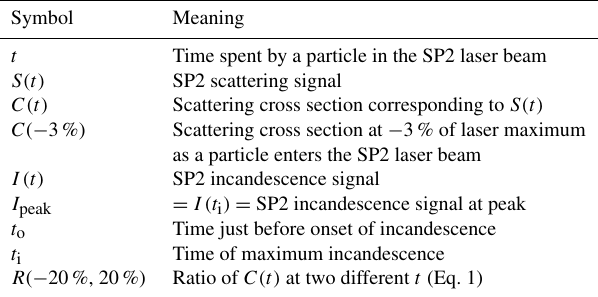
Table 1. Table of symbols used in the text. Symbol